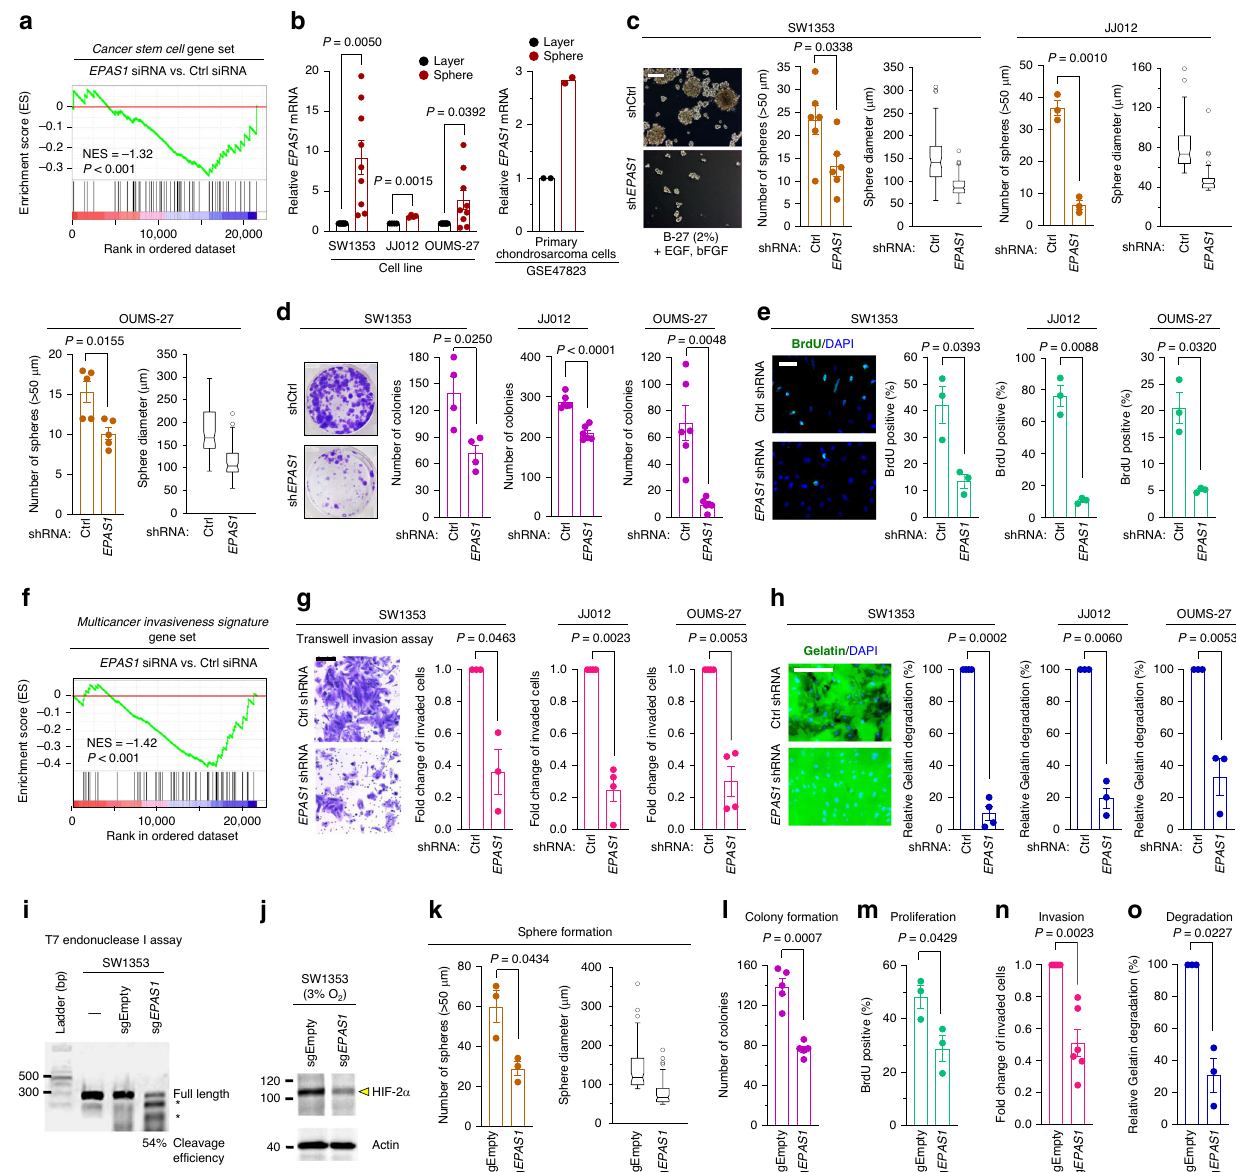
Fig. 4 HIF-2 α expression promotes tumor-initiating and invasive propensity to chondrosarcoma cells. a GSEA was performed for Cancer stem cell gene set using transcriptome data of SW1353 cells transfected with Ctrl or EPAS1 siRNA. NES and nominal P -value are indicated. b qRT-PCR analysis of EPAS1 transcript in SW1353 ( n = 9), JJ012 ( n = 4), and OUMS-27 ( n = 9) cells, grown as a monolayer or spheres (left panel). Relative mRNA level of EPAS1 in primary chondrosarcoma cells (GSE47823; n = 2, right panel). c The number and size of spheres were measured in SW1353 ( n = 6), JJ012 ( n = 3), and OUMS-27 ( n = 5) cells transduced with the indicated lentiviruses. Scale bar: 200 μ m. d Quantitation of colony formation assay by SW1353 (representative images, n = 4), JJ012 ( n = 6), and OUMS-27 ( n = 6) cells expressing indicated shRNAs. e Quantitation of the BrdU-positive cells (green) among SW1353 (representative images, n = 3), JJ012 ( n = 3), and OUMS-27 ( n = 3) cells expressing indicated shRNAs. Scale bar: 50 μ m. f GSEA was performed for Multicancer invasiveness signature gene set using transcriptome data of SW1353 cells transfected with Ctrl or EPAS1 siRNA. NES and nominal P -value are indicated. g Quantitation of invaded SW1353 (representative images, n = 3), JJ012 ( n = 4), and OUMS-27 ( n = 4) cells under indicated conditions. Scale bar: 200 μ m. h Quantitation of relative gelatin degradation area by SW1353 (representative images, n = 4), JJ012 ( n = 3), and OUMS-27 ( n = 3) cells expressing indicated shRNAs. Scale bar: 100 μ m. i Validation of small guide RNA (sgRNA):Cas9-mediated on-target cleavage of EPAS1 by T7E1 cleavage assay. The hyphen above the gel image indicates wild-type gDNA of SW1353 cells not transduced with any lentivirus. Asterisks indicate cleaved PCR amplicon fragments at the expected sizes as an indicative of successful gene editing. The percentage at the bottom of the gel image indicates expected editing ef fi ciency. j Immunoblot of HIF-2 α protein. k – o Quantitation of k sphere formation assay ( n = 3), l colony formation assay ( n = 5), m BrdU incorporation assay ( n = 3), n transwell invasion assay ( n = 6), and o gelatin degradation assay ( n = 3) in SW1353 cells transduced with lentivirus harboring Cas9 and indicated sgRNAs. Data represent mean ± SEM. P -values are from two-tailed t test ( b – e , g , h , k – o ). i , j Full-size agarose gel and immunoblot images are provided in Supplementary Fig.